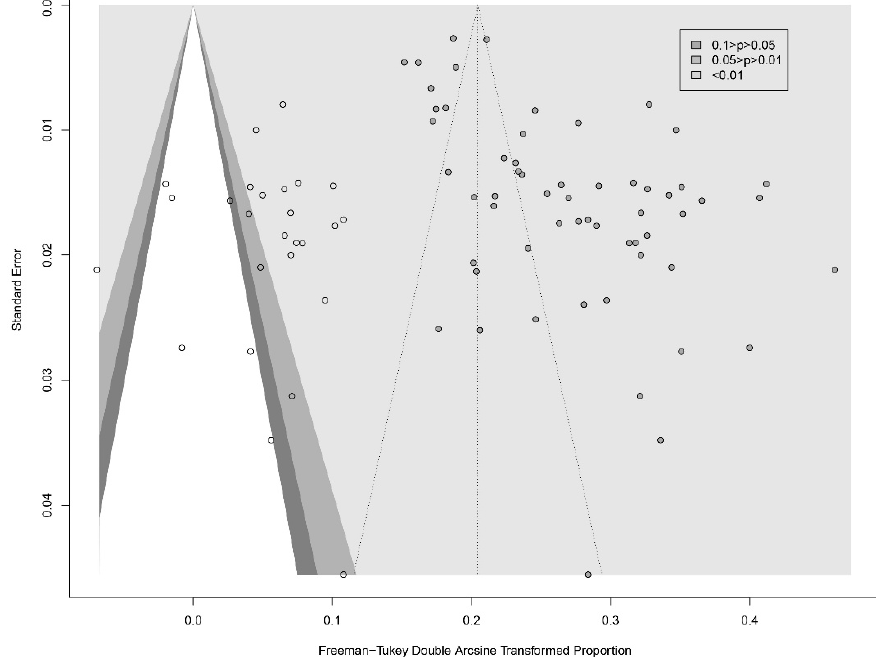
Figure A2. Funnel plot.